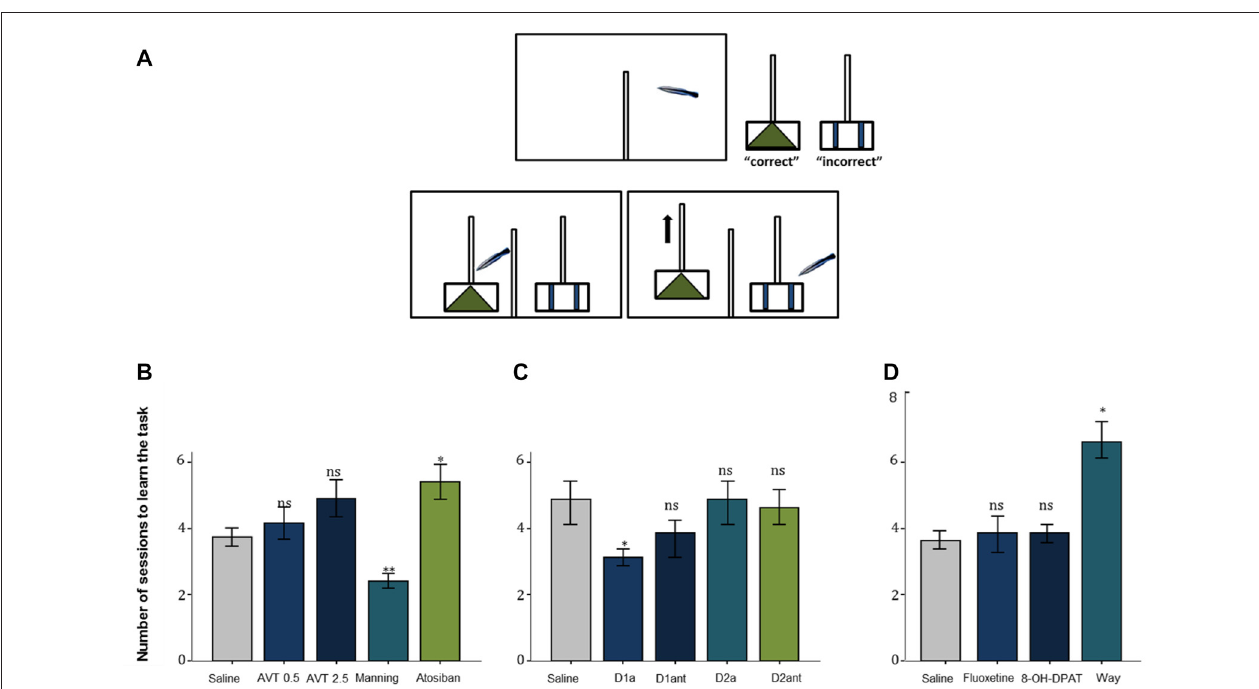
FIGURE 1 | (A) The experimental aquarium (view from the front) was divided into a back compartment (right) and the test compartment (left) with help of an opaque PVC partition. The experiments had three stages, an initial phase, a second in which the two plexiglas plates are placed, and if the cleaner chooses the correct pattern/side, both plates will stay in the aquarium, with one piece of shrimp available, and finally the two plexiglas plates are placed, and if the cleaner chooses the incorrect pattern, only the incorrect plate remains, with no shrimp available. The two Plexiglas plates were visually separated from each other with help of a dividing transparent partition wall in-between the plates. The tested fish could move into the test compartment when an opaque partition at the side of the back compartment is pulled up. (B) The effect of the neuropeptides arginine vasotocin (AVT), Manning compound (Manning), and atosiban on learning behavior of the cleaner fish L. dimidiatus in the ecologically relevant cue-learning task, compared with a control (saline). (C) The effect of D1 receptor agonist (D1a), D1 antagonist (D1ant), D2 agonist (D2a) and D2 antagonist (D2ant) on L. dimidiatus cue- learning task, compared with a control (saline) and (D) The effect of fluoxetine (FLX), 8-OH-DPAT and WAY 100.635 on the number of sessions to learn the cue task, compared with the saline control. Symbols above bars represent p values, which refer to planned comparisons of least squares means effect of each compound treatment group against the reference (saline) group ( ∗ p < 0.05; ∗∗ p < 0.01; ns > 0.05); error bars represent the standard error of the mean. Cleaners had a maximum of eight sessions to learn the